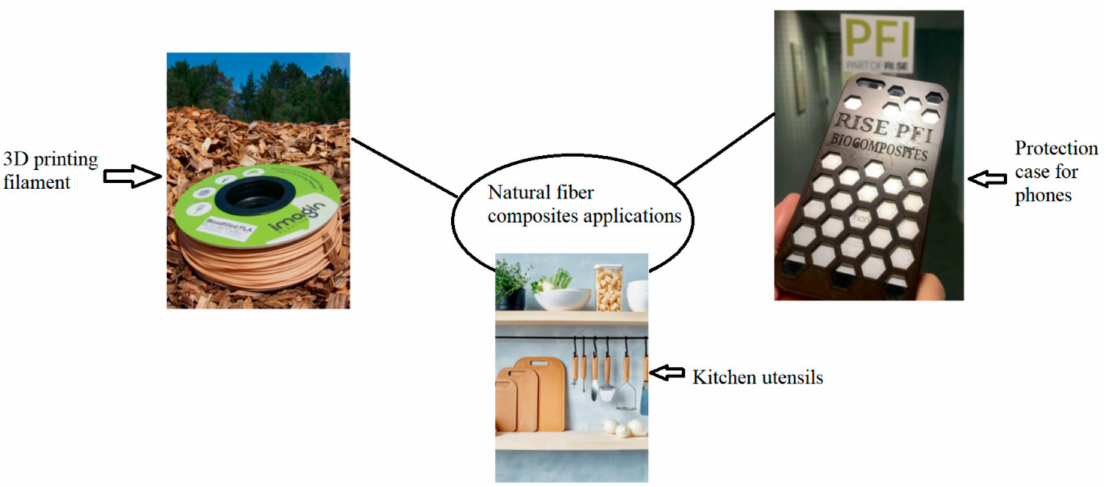
Figure 22. Selective applications of natural fiber composites. Reprinted with permission from the publisher